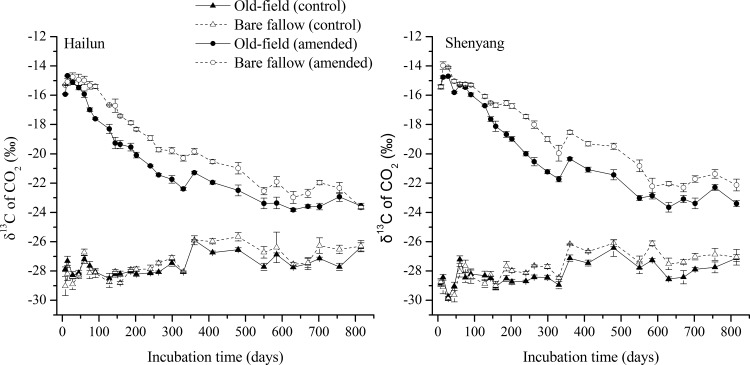
Variation in δ13C values of respired CO2-C for soils with or without maize leaves amendment taken from old-field and bare fallow treatment at Hailun (left) and Shenyang (right) station throughout the 815-day incubation.Error bars show ±1 SE.